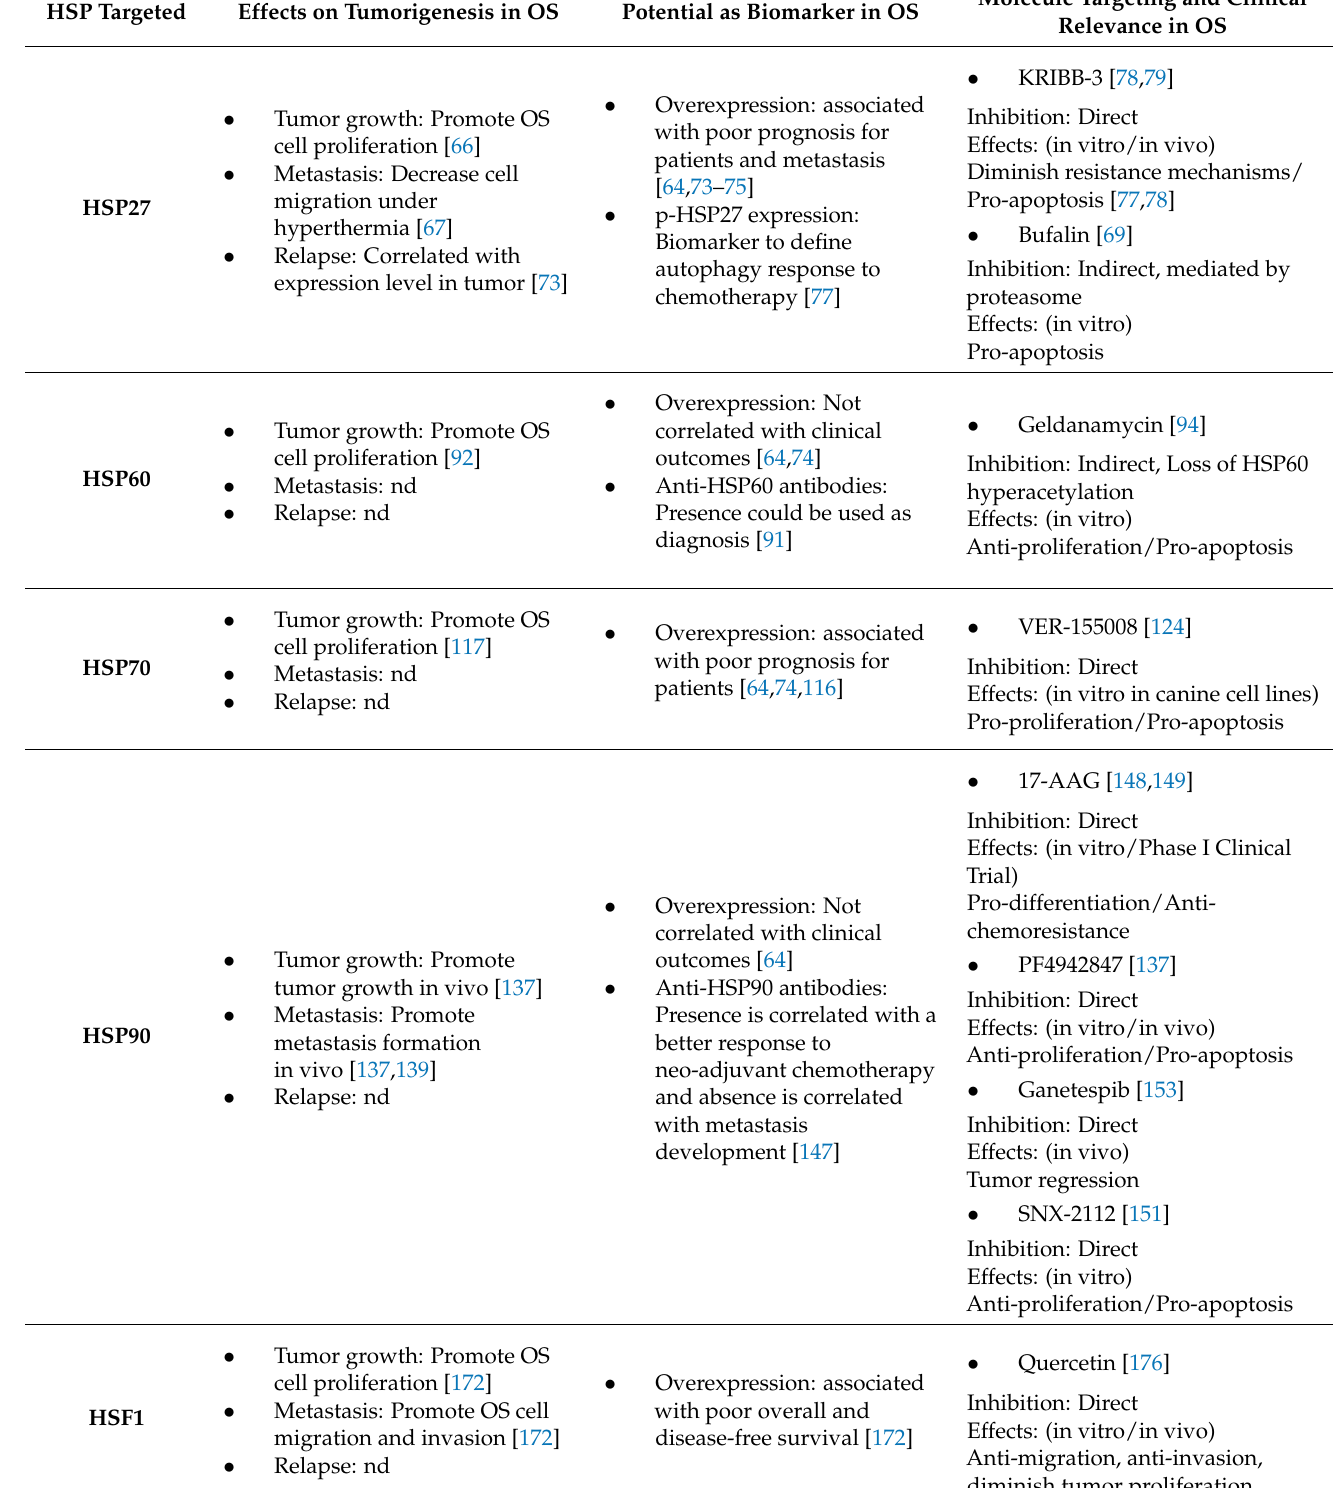
Table 1. Overview of HSPs and HSF1 involvement in tumorigenesis and of their inhibitors tested in OS (nd: no data). HSP